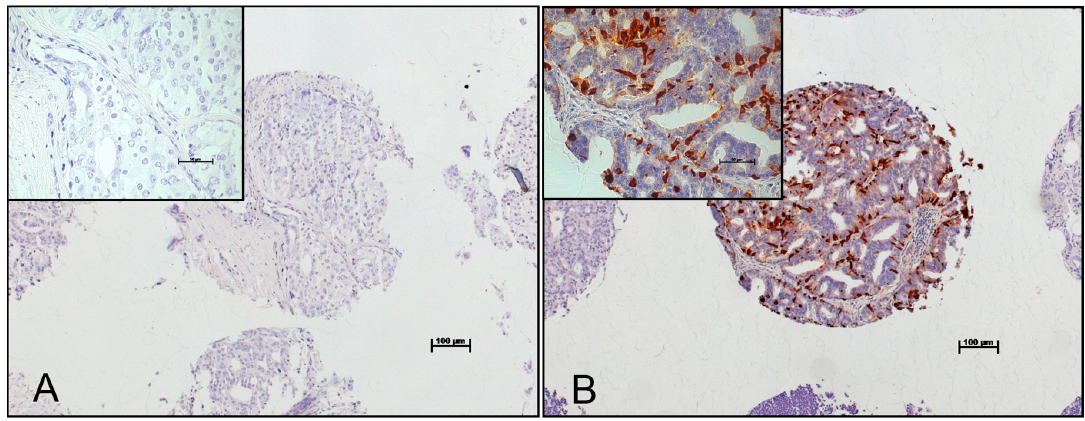
Figure 3. No Chromogranin A expression in ( A ) primary prostate cancer; and ( B ) high Chromogranin A expression in a lymph node metastasis.